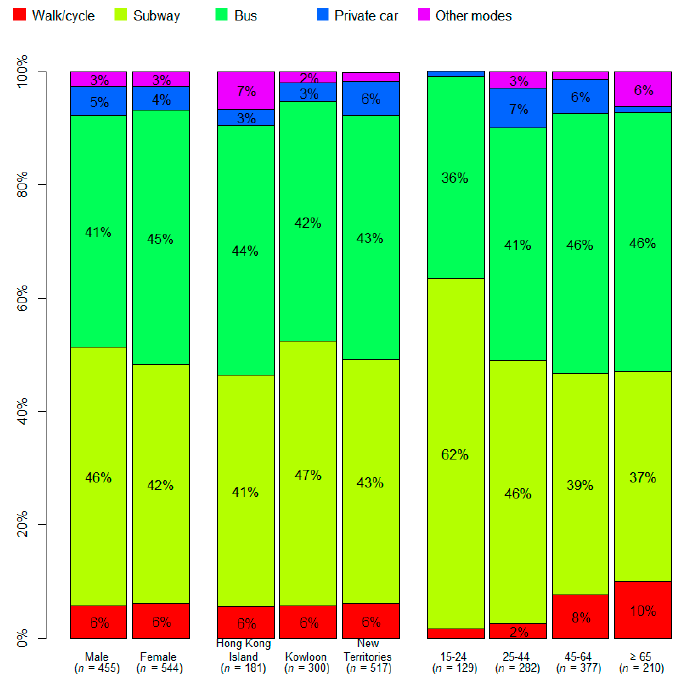
Figure 2. Subgroup analysis on daily transport mode.